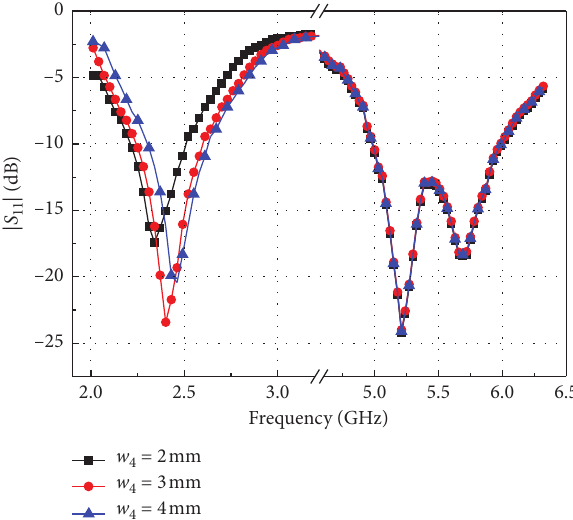
Figure 4: The simulated | S 11| for different l